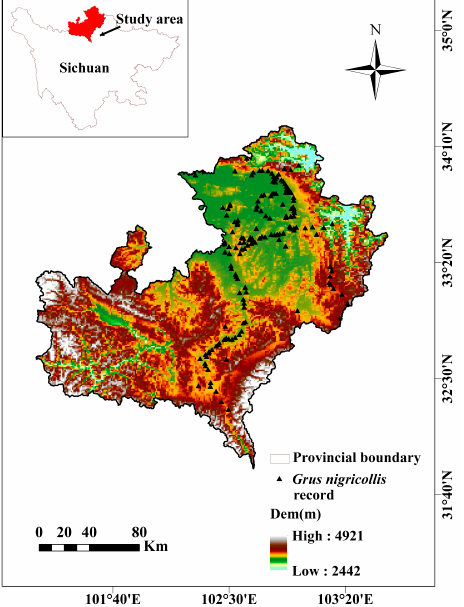
Figure 1. The presence data of black-necked